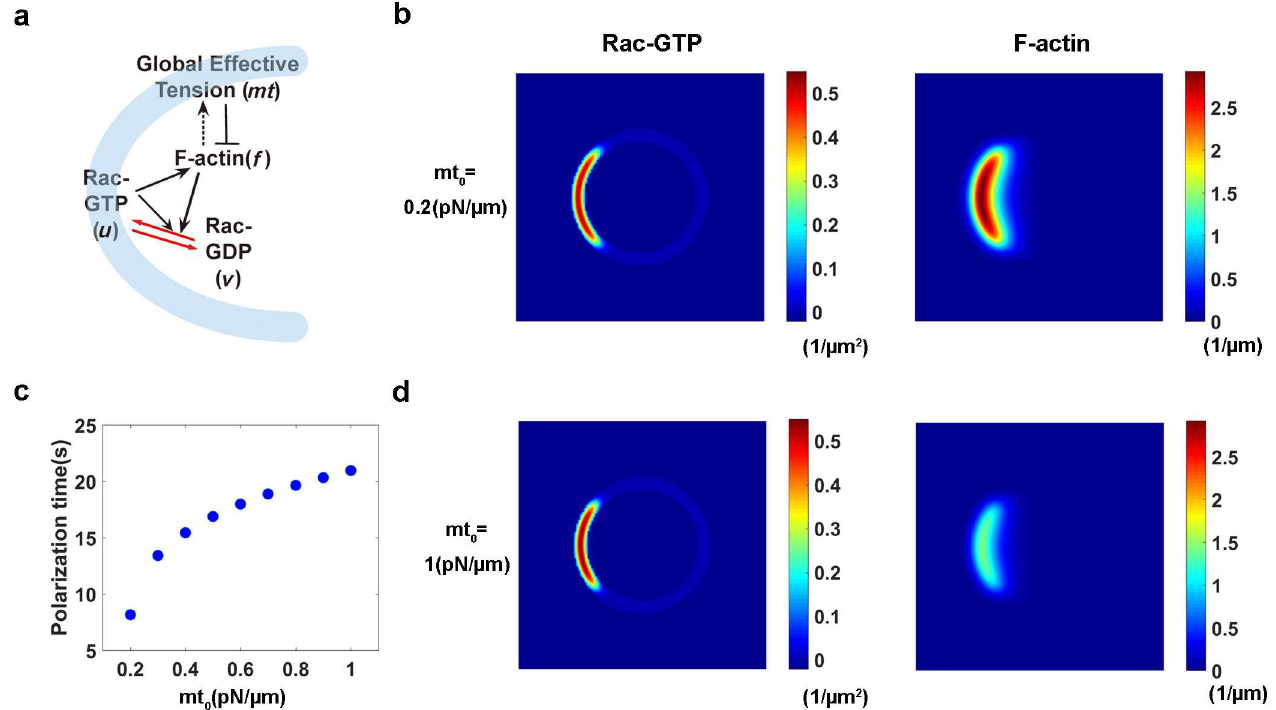
Fig 1. The mechano-chemical model of cell polarization. (a) Schematic diagramof the regulatorynetwork in the model. Membranetension( mt ) globallyinhibits (denotedby— | ) the formation of F-actin ( f ) in the cell. F-actin polymerization increases(black dashedarrow) membranetension, and activates (black solid arrow) membrane-boundRac-GTP (coloredin light blue) ( u ). Rac-GTP is also activated by stimulationand itself. In addition,Rac-GTP on the membraneand Rac-GDP ( v ) in the cytosol interconvert (red arrow). (b) The steady-state spatial profilesof Rac-GTP, Rac-GDP and F-actin in a polarized cell with mt 0 = 0.2 pN/ μ m .Rac-GTP and F-actin congregateat the front of the cell in the membraneand cytoplasm, respectively. (c) Increasedmembranetension elongatesthe polarizationtime in responseto the same stimulus. (d) As mt 0 increasesto 1 pN/ μ m , the distributionof Rac-GTP shrinks, and the maximum concentration of Rac-GTP increases.